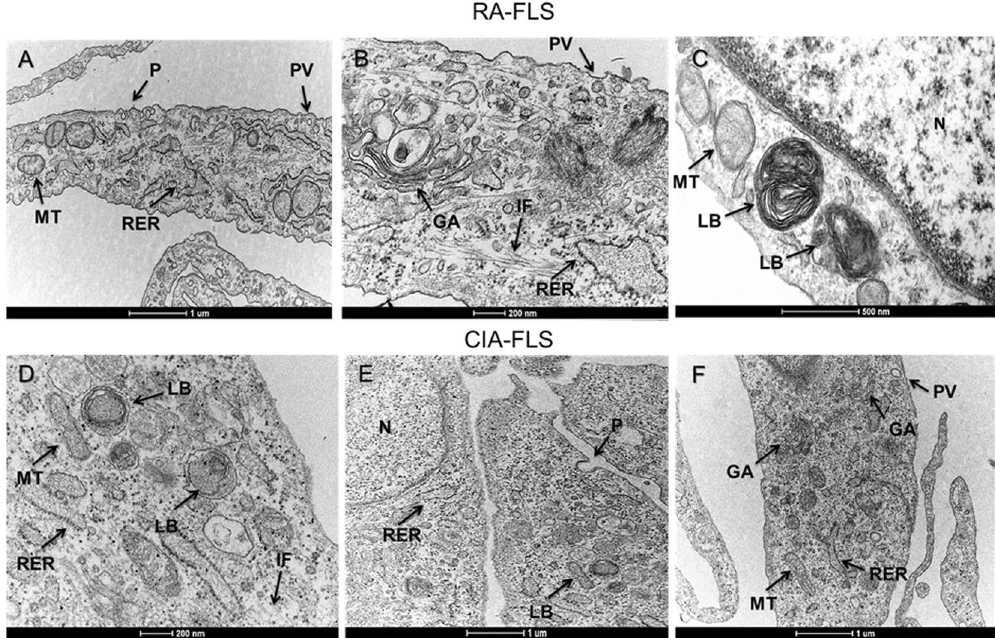
Fig. 3 Electron microscopic analysis of fibroblast-like synoviocytes from patients with rheumatoid arthritis ( A – C ) and mice with collagen-induced arthritis ( D – F ). Both groups showed an abundant cytoplasm containing mitochondria (MT) with extensive rough endoplasmic reticulum (RER), with an euchromatic nucleus (N), mitochondria (MT), Golgi apparatus (GA), intermediate filaments (IF), lamellar bodies (LB) showing typical concentric walls, and pinocytotic vesicle (PV) in the cell membrane, showing the presence of pinocytosis (P). (4200-fold, 16,500-fold and 20,500-fold magnifications were